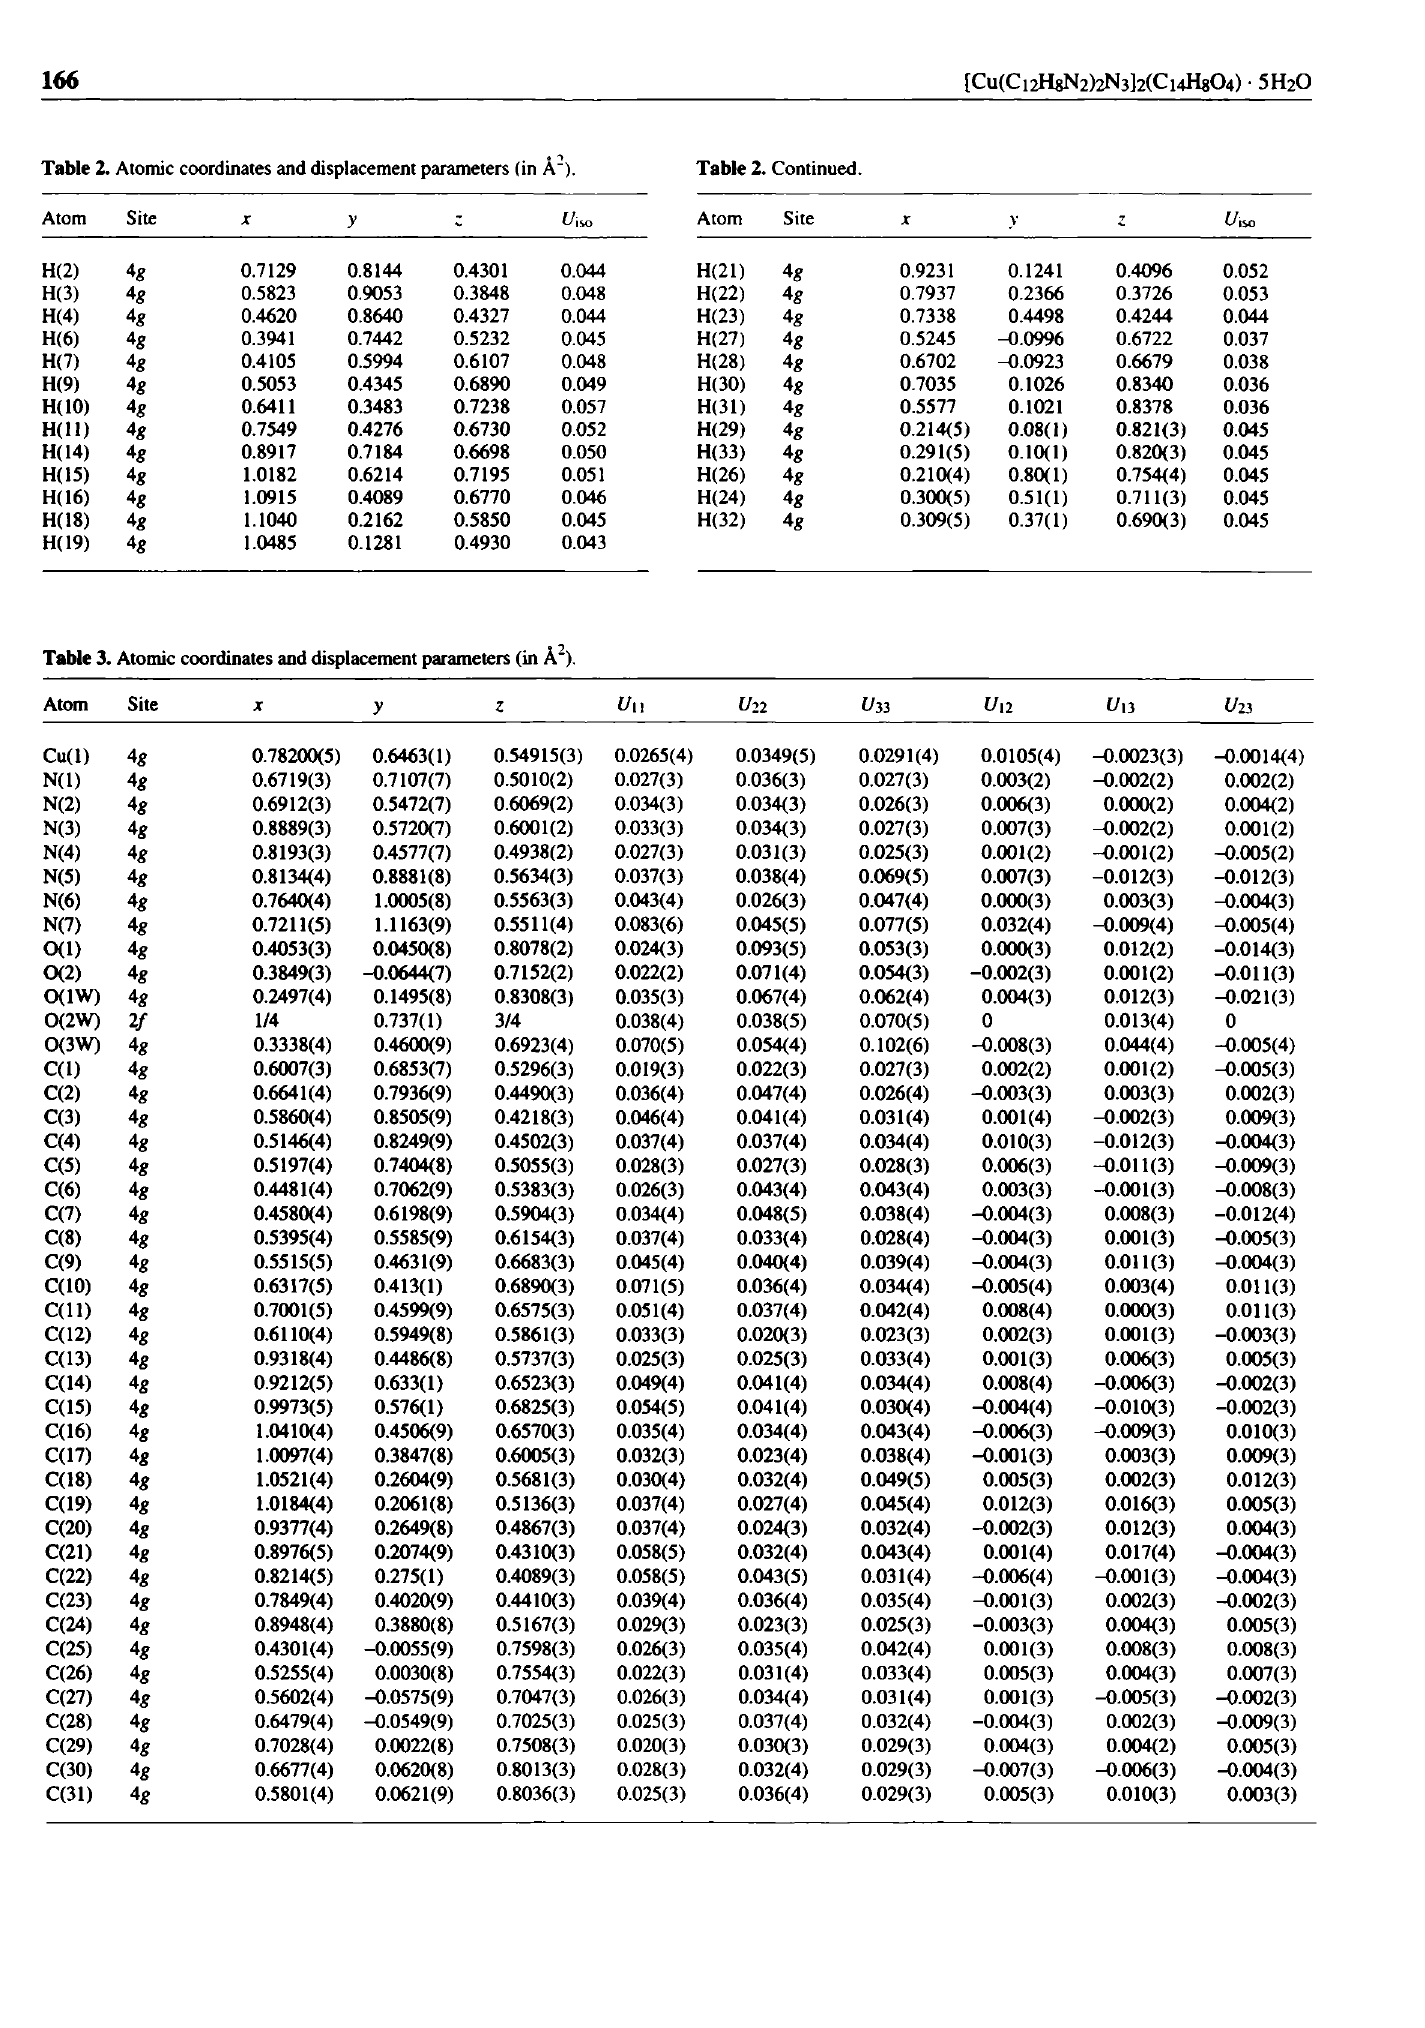
Table 3. Atomic coordinates and displacement parameters (in À 2